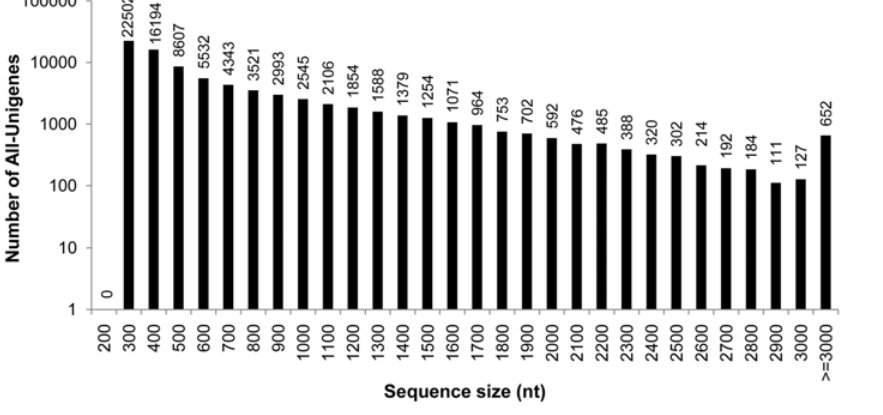
Fig 1. Size distribution of sequences in the